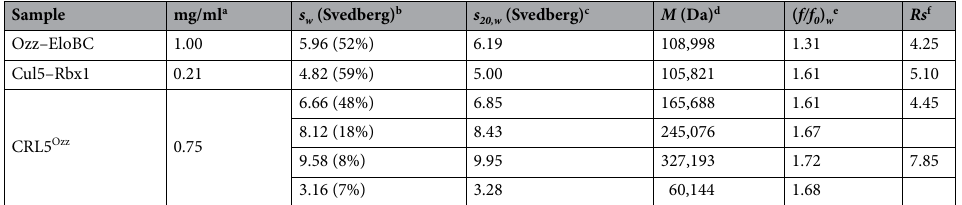
Table 3. Best-fit values and estimates of the 2D c ( s,f/f 0 ) analyses of Ozz–EloBC and Cul5–Rbx1, and CRL5 Ozz (Ozz–EloBC + Cul5–Rbx1) in 10 mM sodium phosphate, 1.8 mM potassium phosphate pH 7.2, 137 mM NaCl and 0.27 mM KCl buffer at 20 °C. a Total concentration of sample in milligram per milli liter. b Weight-average sedimentation coefficient s w calculated from the 2D c ( s,f/f 0 ) model with percentage protein amount of total protein in parenthesis. c Standard sedimentation coefficient ( s 20,w -value) in water at 20 °C. d Estimated molar mass calculated from ( s w ,f/f 0 ) from the 2D c ( s,f/f 0 ) model. e Weight-average frictional ratio ( f/f 0 ) w calculated from the 2D c ( s,f/f 0 ) model. f Stokes radius (nm) obtained from contour plot of the c ( s,M ) distribution.